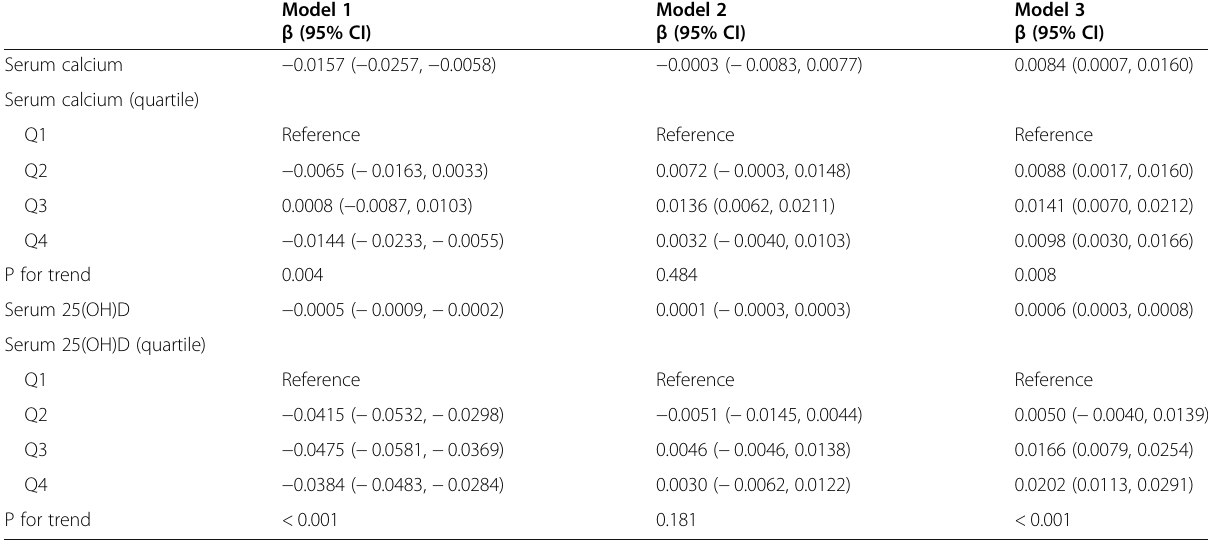
Table 2 Associations of serum calcium, 25(OH)D with total bone mineral density